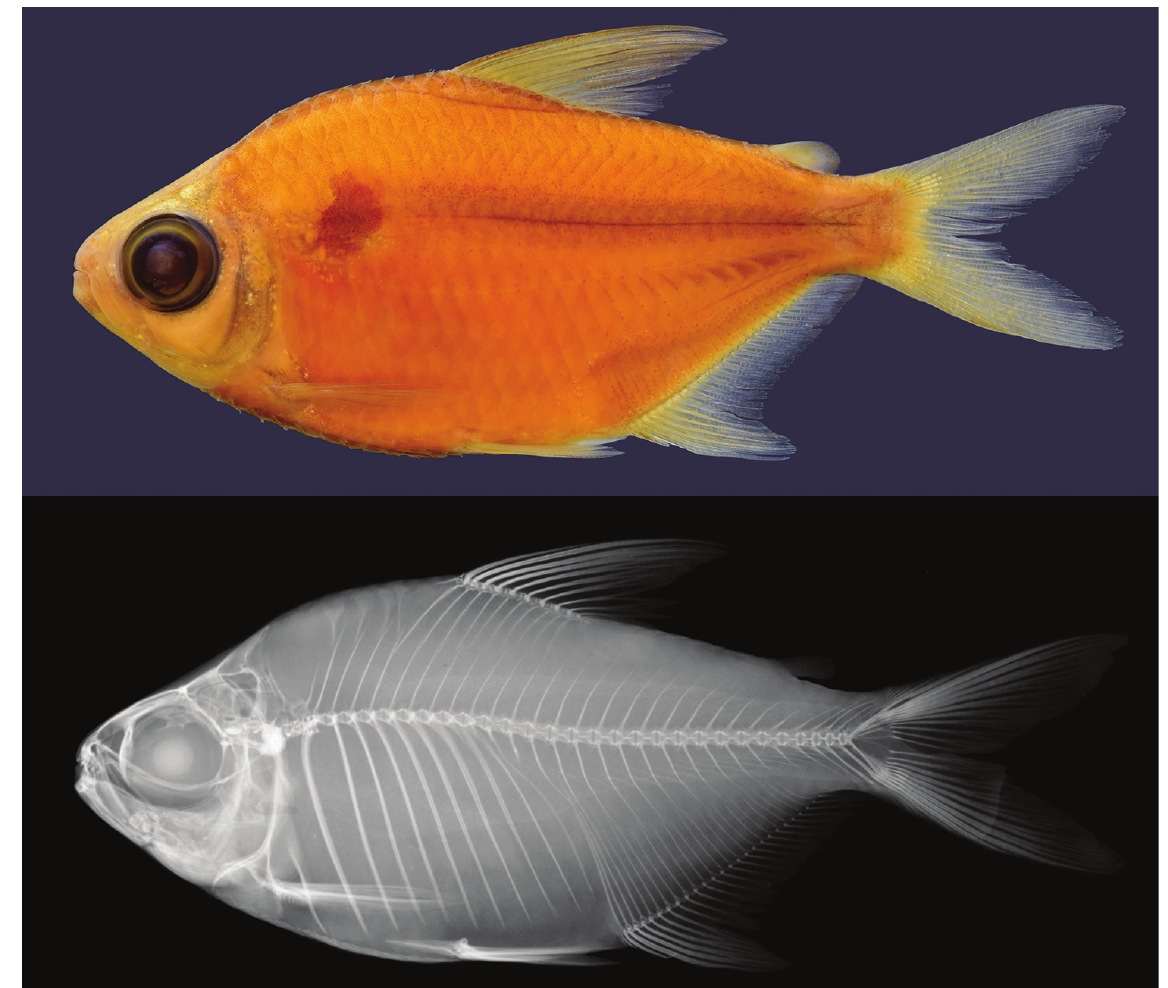
Figure 1. Moenkhausia britskii , MZUSP 120691, holotype, 52.9 mm SL, from Içá River, Amazon